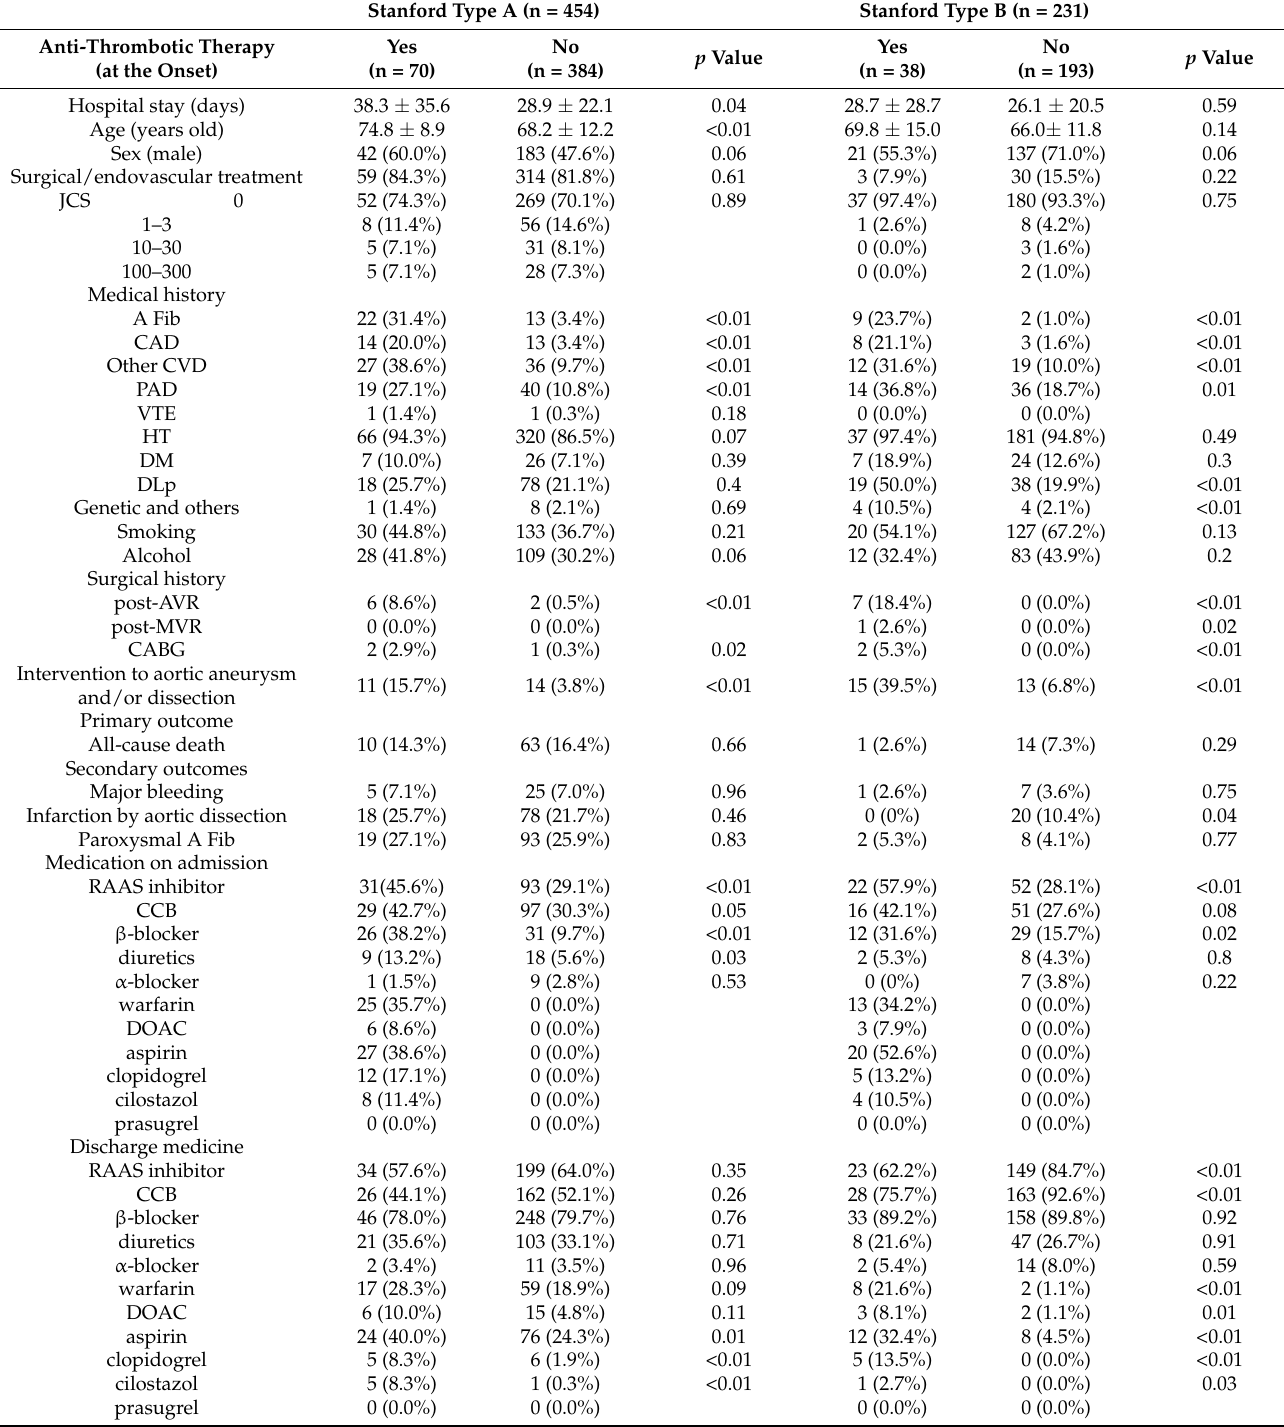
Table 1. Clinical characteristics of TRANSFERRED acute aortic dissection patients with and without anti-thrombotic